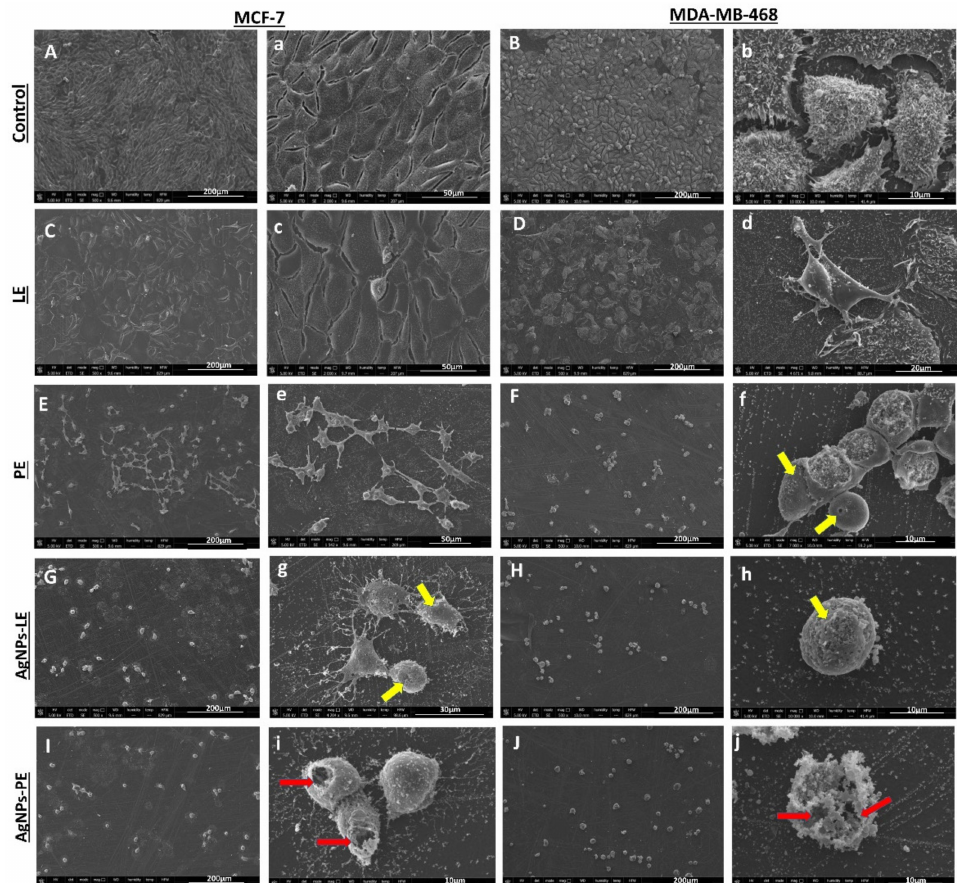
Figure 6. Microscopy micrographs of MCF-7 and MDA-MB-468 cells after 6 days of IC 50 treatments with different compounds. Cell controls are shown in ( A , a , B , b ) under treatment with LE extract ( C , c , D , d ) showed cells with epithelial form strongly adhered to the surface of the culture coverslip, and PE show cells with loss of microvilli ( E , e , F ), in addition to multiple pores (arrows yellow) ( f ), the micrographs of the cells treated with AgNPs-LE show a decrease in cells compared to the controls ( G , H ). Cells treated with NPs also showed pore formation (yellow arrows, g , h ) and a flatter cell surface than controls, due to the loss of microvilli and filopod structures. Cells treated with AgNPs-PE ( I , J ) also show cell decrease, in addition to giant cells with destructured cytoplasmic membrane (red arrows, i , j ) Scale bar (200–10 µ